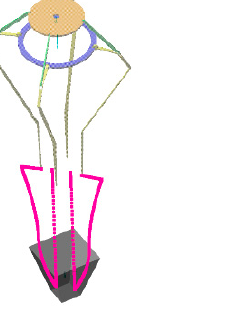
Figure 12. Trajectory curve of fingers movement.